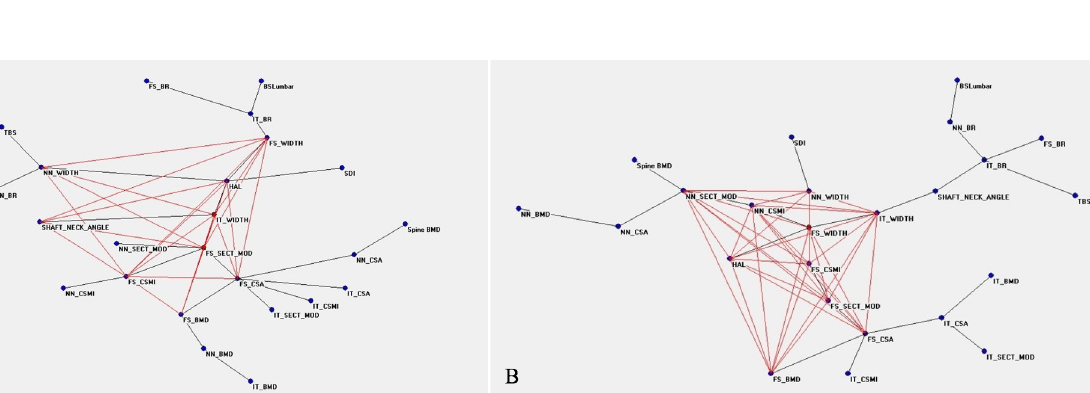
Fig 2. Semantic map showing the relations between the investigated anagraphic, anthropometric, densitometric, biochemical and clinical parameters in the whole population after treatment.